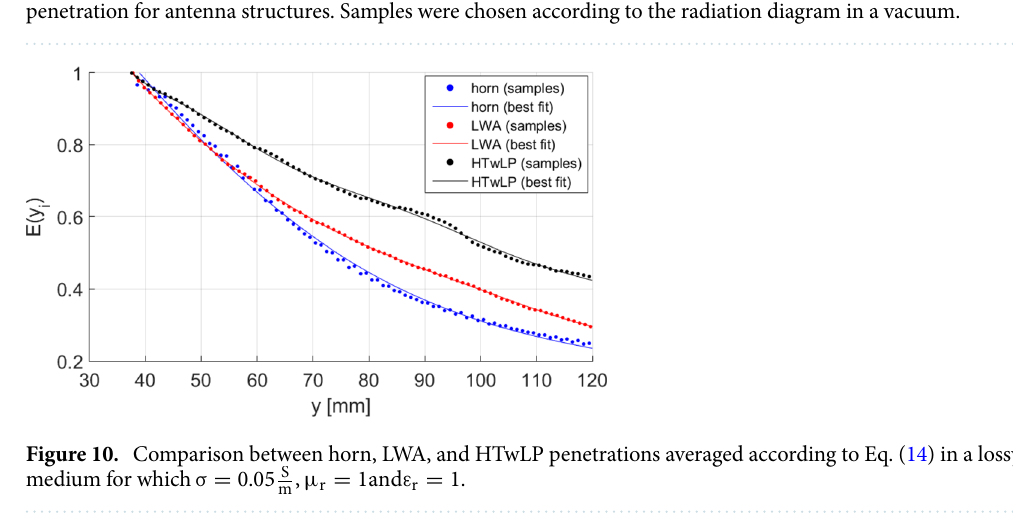
Figure 9. Chosen samples for ( a ) horn, ( b ) LWA microstrip, and ( c ) HTwLP to compute the average penetration for antenna structures. Samples were chosen according to the radiation diagram in a vacuum.